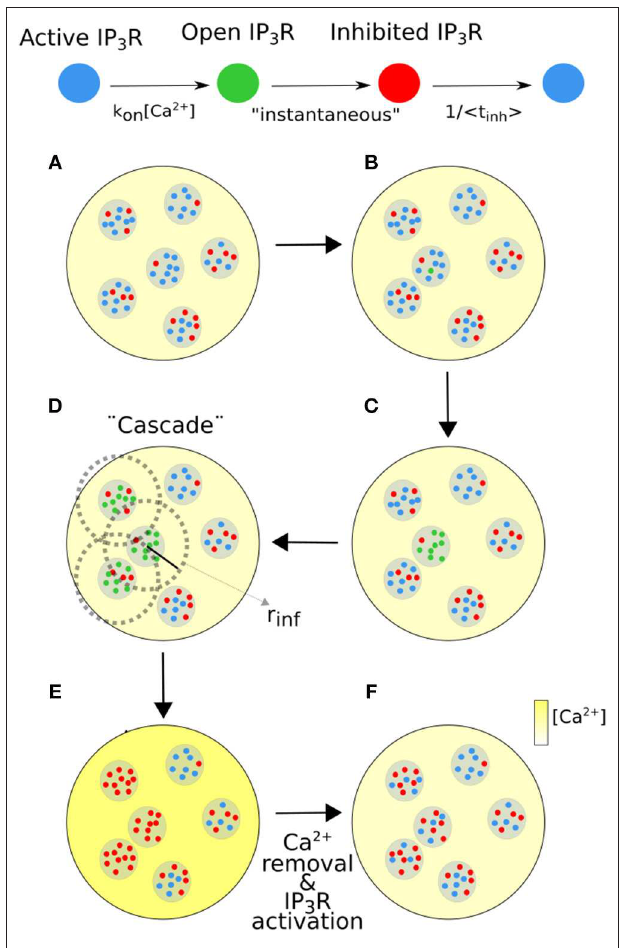
FIGURE 1 | Scheme of the numerical simulation steps. (A,B) An active IP 3 R (blue dot) becomes open with a probability per unit time that depends on [Ca 2 + ]. (C) An open IP 3 R (green dot) induces the opening of all active IP 3 Rs in its cluster. (D) A cluster with N o open IP 3 Rs induces the opening of all active IP 3 Rs inside clusters that are within a distance, r inf , from it (dotted circle). r inf is an increasing function of N o and (cytosolic) [Ca 2 + ] (yellow color bar). This “cascade” is instantaneous. (E) [Ca 2 + ] increases and the open IP 3 Rs become inhibited (red dots). (F) When Ca 2 + is removed the inhibited IP 3 Rs can become